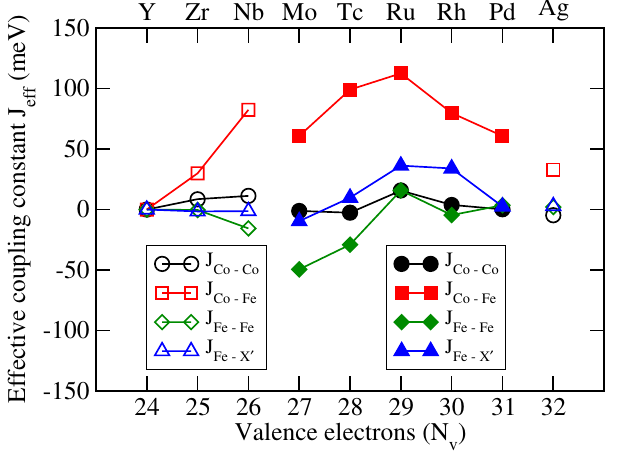
Figure 13. Effective exchange coupling constants for CoX ′ FeSi alloys. Open symbols: Type-I structure, Filled symbols: Type-II